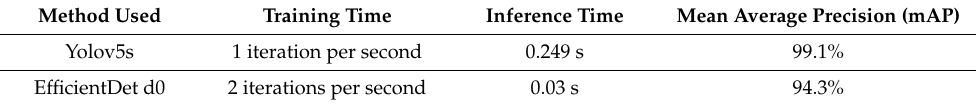
Table 4. Comparison of inference time, training time, and mean Average Precision